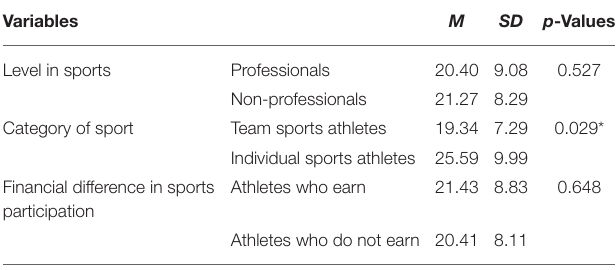
TABLE 1 | Sample description.